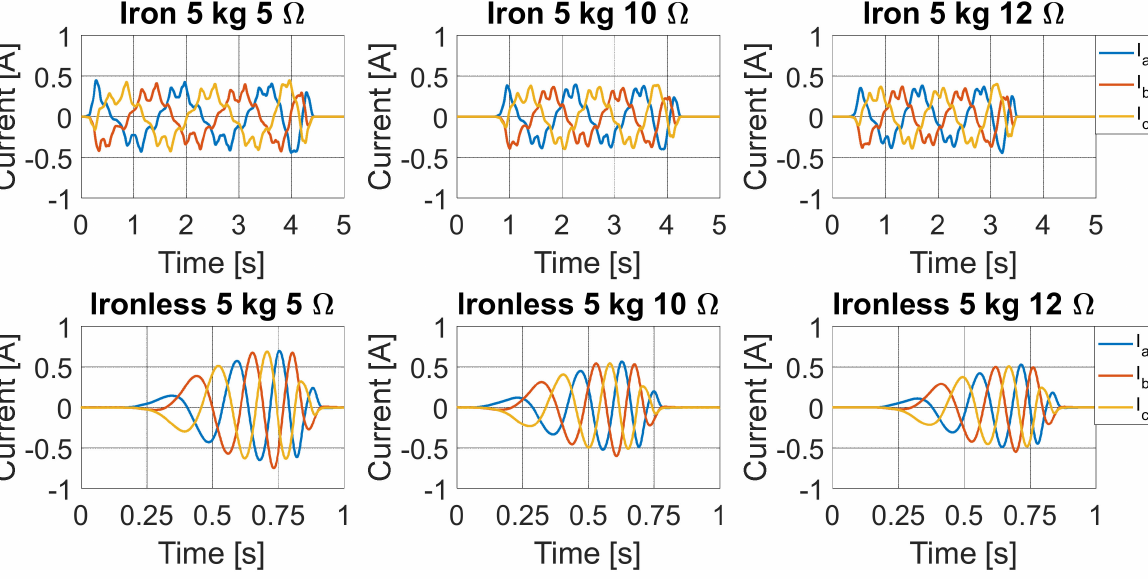
Figure 12. Load currents trends of the 5 kg test with a resistance load equal to 5 Ω , 10 Ω and 12 Ω